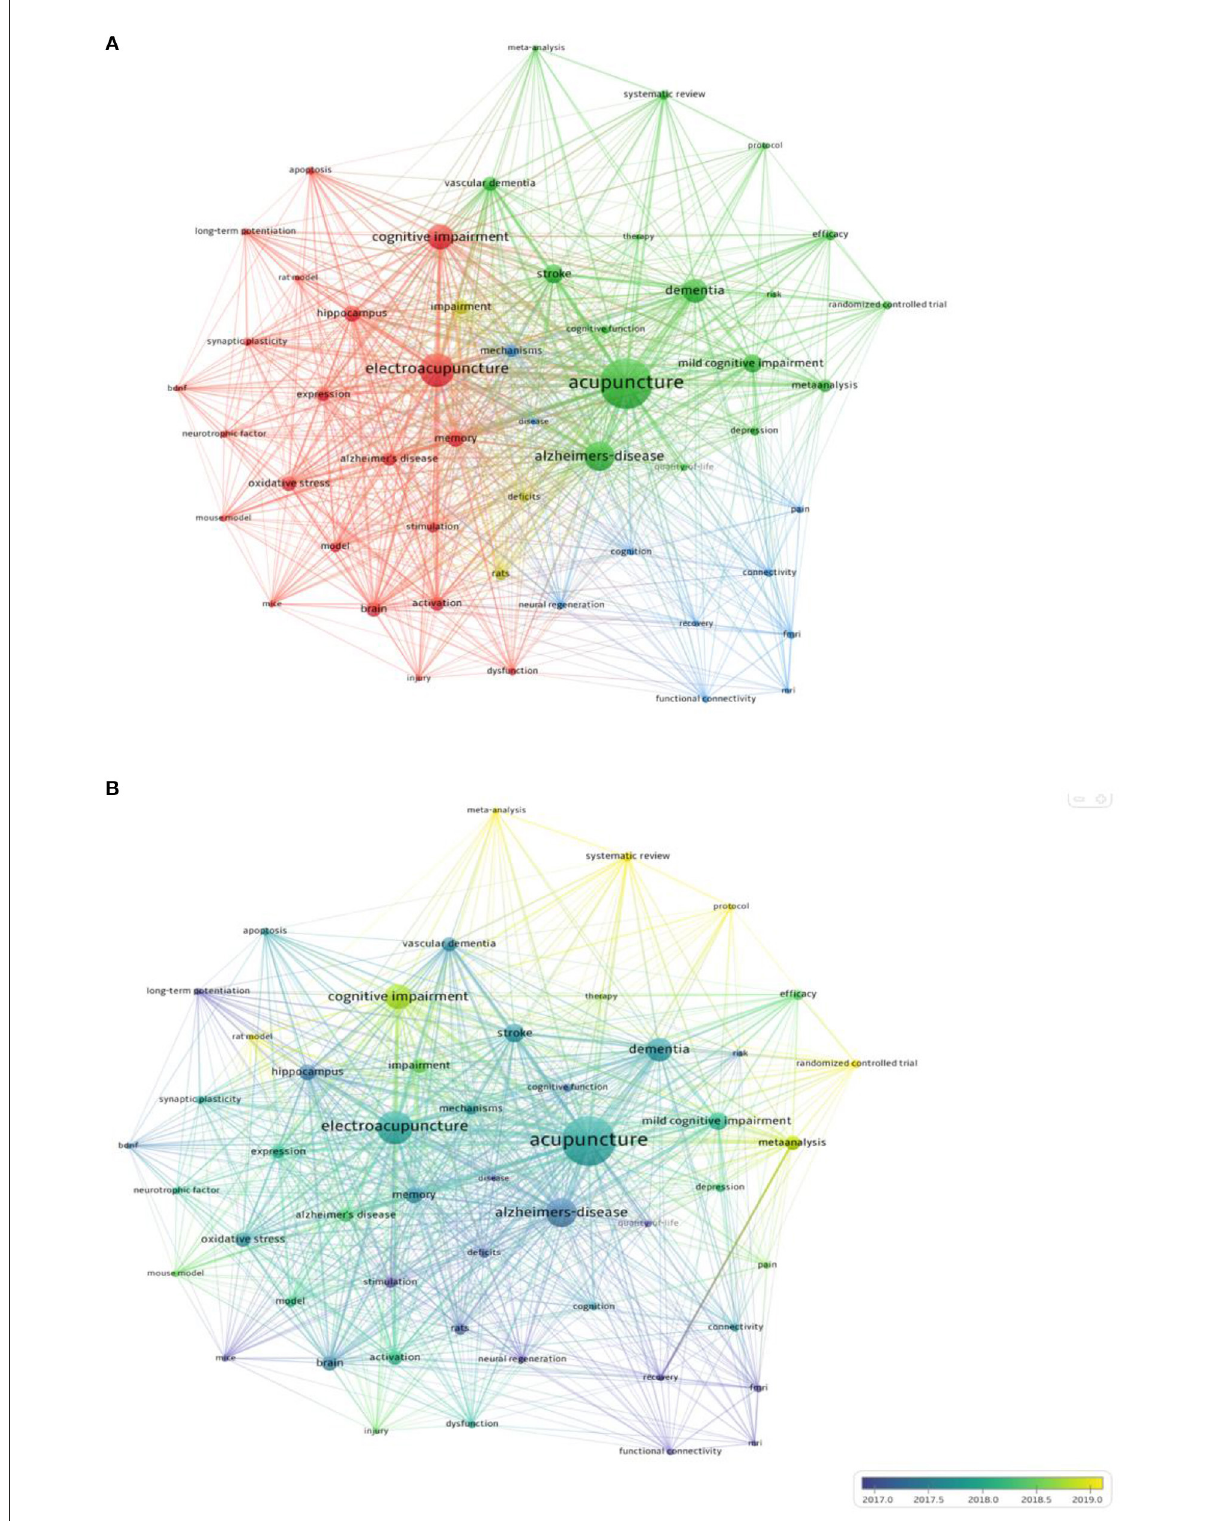
FIGURE8 Analysis of keywords. (A) Co-occurrence network of keywords. (B) Analysis of keywords by average publication year (blue: earlier, yellow: